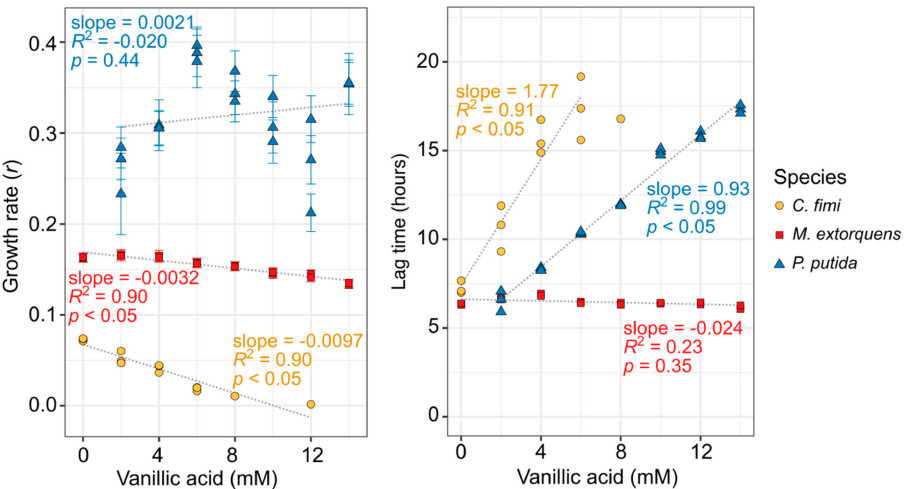
Figure 2. Vanillic acid inhibits the growth of C. fimi and P. putida substantially, but has only a minor effect on M. extorquens growth. Each organism was grown in pure culture in mineral medium and OD 600 monitored for up to 60 h with a range of vanillic acid concentrations (original growth curves are shown in Figure S2). C. fimi was provided with cellobiose and M. extorquens with methanol as growth substrates, whereas P. putida was able to use the vanillic acid as a growth substrate. Each point represents a biological replicate. Only growth rates for which R 2 > 0.9 are shown here. In the left panel, error bars denote the standard error of the fitted growth rate. For C. fimi and P. putida , lag time and growth rate are dependent on vanillic acid